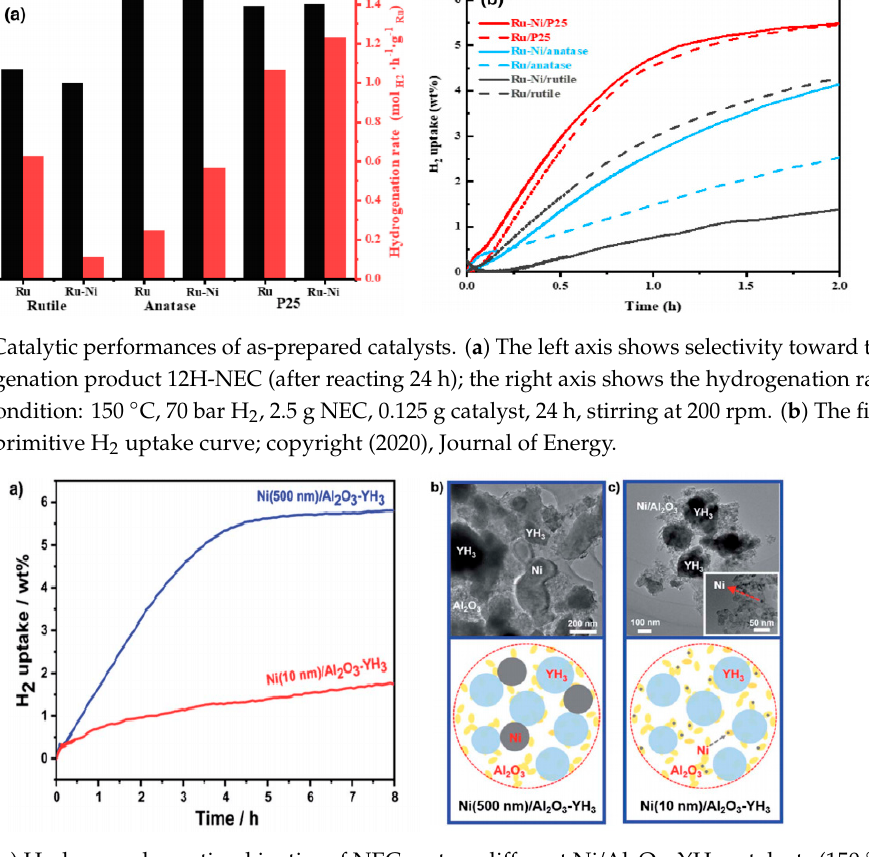
Figure 3. ( a ) Hydrogen absorption kinetics of NEC on two different Ni/Al 2 O 3 –YH 3 catalysts (150 °C, 3 MPa H 2 , 1.00 g NEC, 25 mg Ni / Al 2 O 3 , and 100 mg YH 3 ). ( b , c ) TEM images and schematic